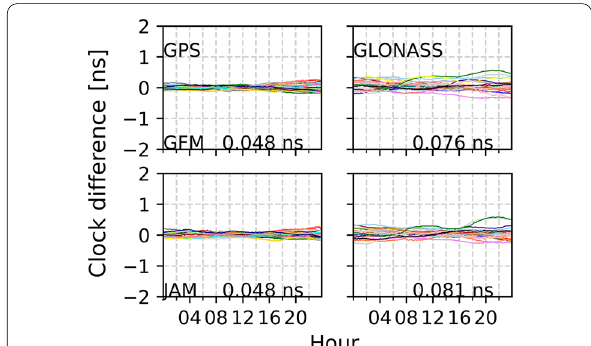
Fig. 5 Clock difference of GFM and JAM with respect to COM for GPS and GLONASS with correction of the constellation-specific nonlinear variation on DOY 001, 2018. The values in black are the mean STDevs for each constellation Fig. 6 Processing flowchart of multi-GNSS combined